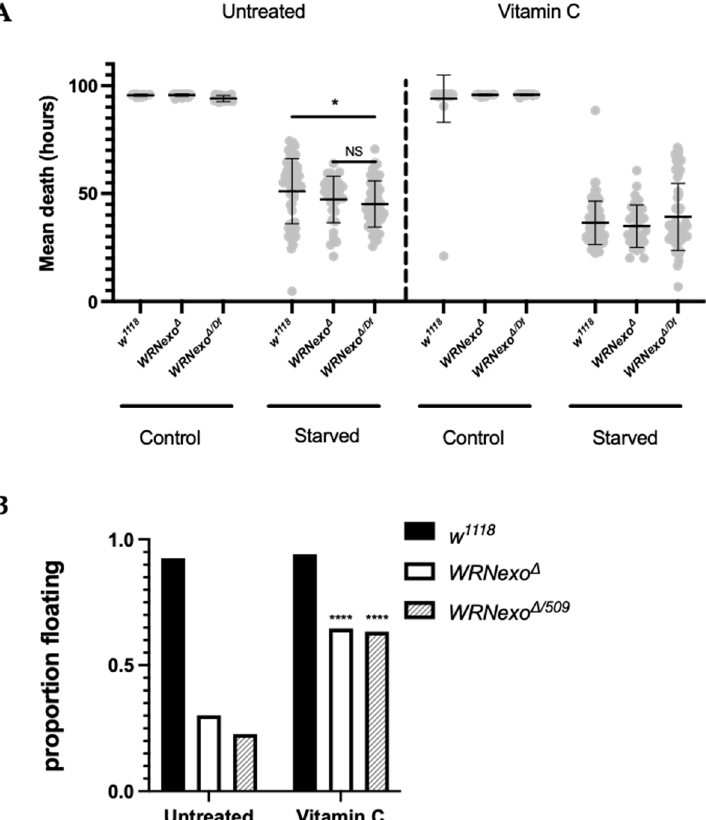
Figure 3. WRNexo ∆ show sensitivity to starvation that is impacted by treatment with vitamin C. ( A ) WRNexo females have shorter mean lifespans under starvation compared to age-matched w 1118 controls. Vitamin C-treated flies have similar lifespans regardless of genotype (2-way ANOVA and Tukey’s multiple comparisons post hoc test, * p < 0.05, ±SD, n = 16–80 flies/genotype). Df = deficiency strain: WRNexo Δ /Df509 for untreated experiments and WRNexo Δ /Df6178 for experiments with vitamin C treatment. ( B ) Vitamin C treatment leads to higher levels of body fat in WRNexo Δ larvae (Fisher’s exact test, **** p < 0.0001, Untreated: w 1118 n = 660, WRNexo ∆ n = 288; WRNexo ∆ /Df509 n = 207; Vitamin C-treated: w 1118 n = 275, WRNexo ∆ n = 325; WRNexo ∆ /Df509 n = 71, where n is total